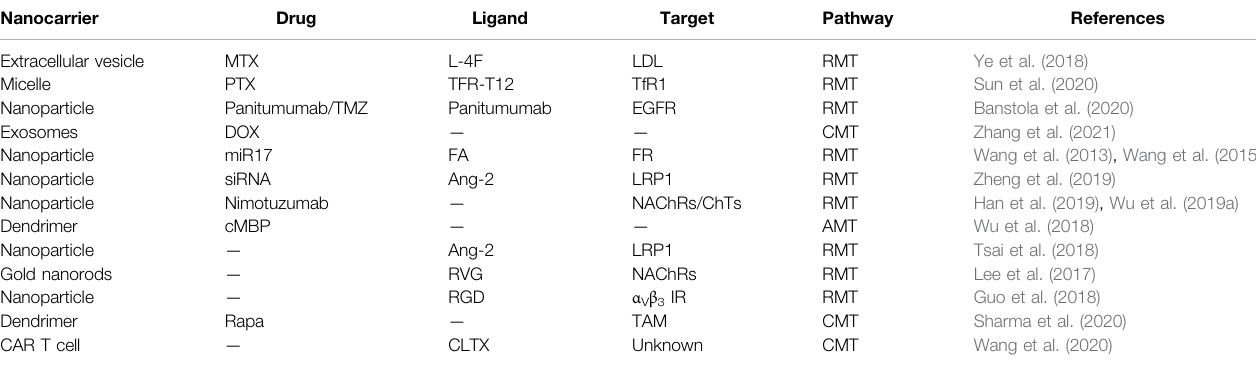
TABLE 1 | Examples of nanotherapeutics for GBM treatment.